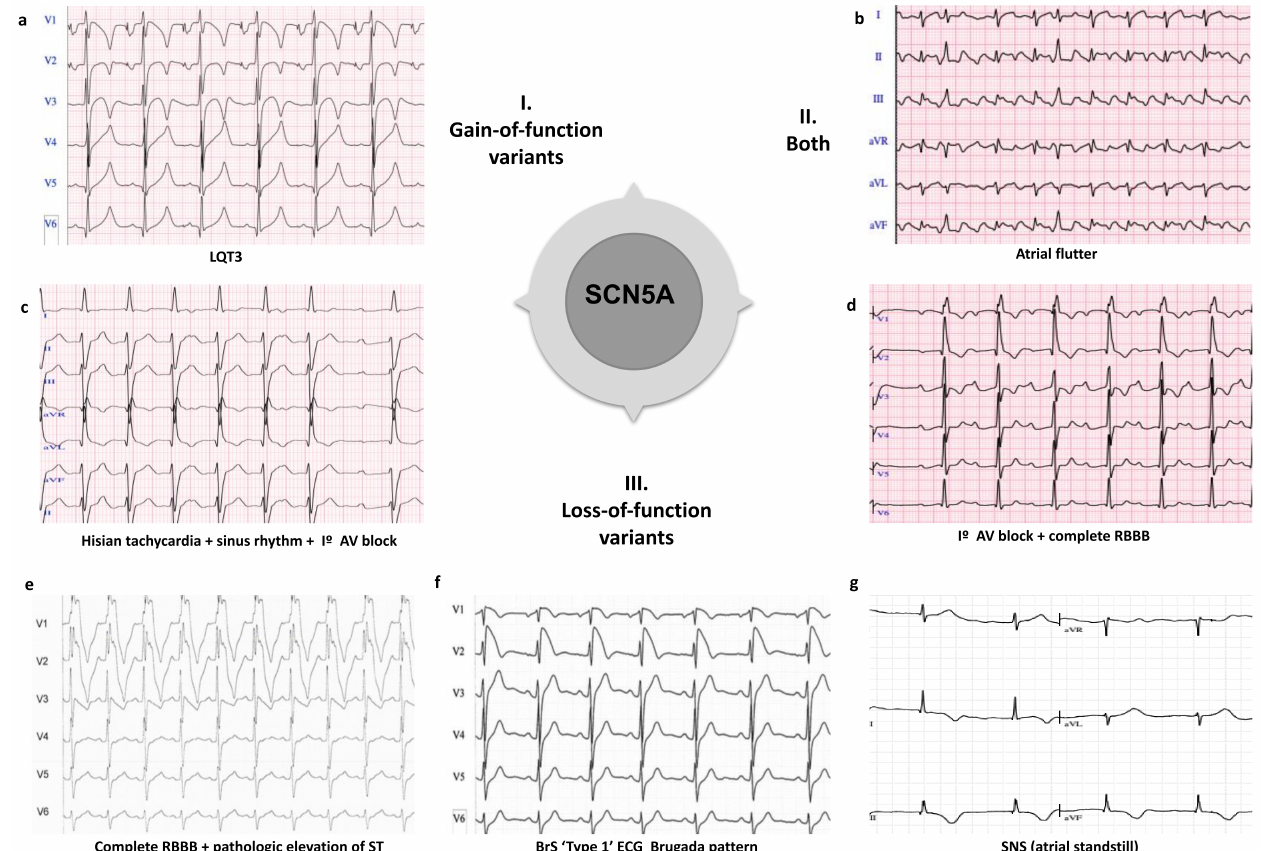
Figure 2. Examples of clinical overlap due to pathogenic variants in the SCN5A gene. I. Phenotype caused by gain-of-function variants in the SCN5A gene: ( a ) LQTS (Long QT syndrome type 3); II. Phenotype caused by both gain-of-function and loss-of-function variants in the SCN5A gene: ( b ) Atrial flutter; III Phenotypes caused by loss-of-function variants in the SCN5A gene: ( c ) Hisian tachycardia + sinus rhythm + I ◦ AV block; ( d ) I ◦ AV block + complete RBBB (right bundle branch block); ( e ) Complete RBBB + pathologic elevation of ST; ( f ) BrS (Brugada syndrome) ‘type 1’ ECG; and ( g ) SNS (sinus node syndrome), atrial